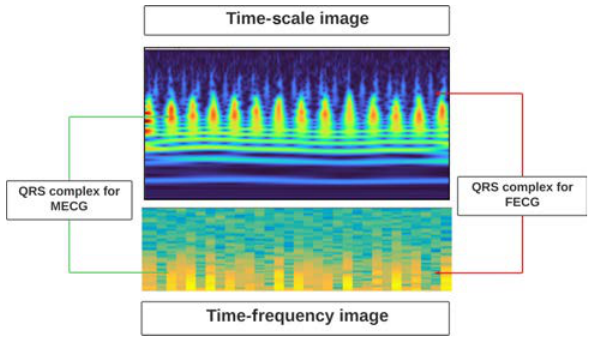
Fig. 3 Time-scale and time-frequency domain of mixture signal.